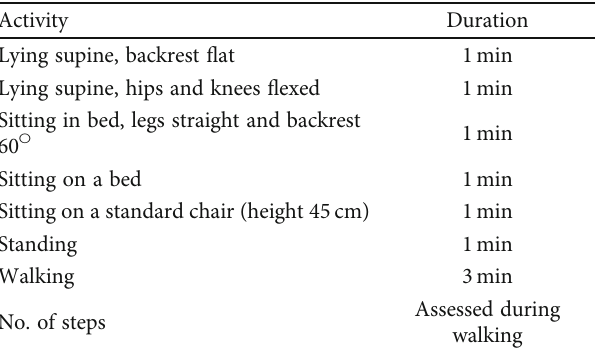
Table 1: Standardized